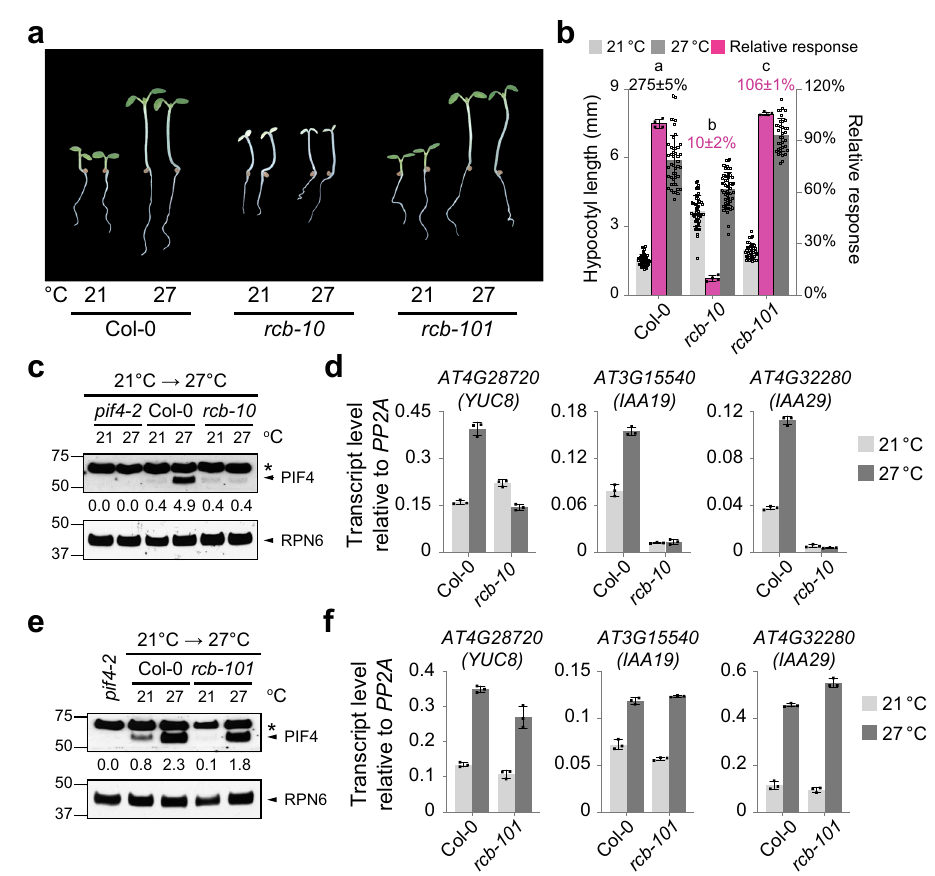
Fig. 5 RCB is required for thermoresponsive PIF4 accumulation. a Representative images of 4-d-old Col-0, rcb-10 , and rcb-101 seedlings grown in 50 μ molm − 2 s − 1 R light at either 21 or 27°C. b Hypocotyl length measurements of the seedlings shown in ( a ). The light- and dark-gray columns represent hypocotyl length measurements in 21°C and 27°C, respectively. The percent increase in hypocotyl length (mean± s.d., n = 3 biological replicates) of Col-0 at 27°C is shown in black above its columns. The magenta columns show the relative response. Error bars for the hypocotyl measurements represent the s.d. ( n > 30 seedlings); error bars for the relative responses represent the s.d. of four biological replicates. The centers of the error bars represent the mean values. Purple numbers show the mean ±s.d. values of relative responses and different letters denote statistically signi fi cant differences in